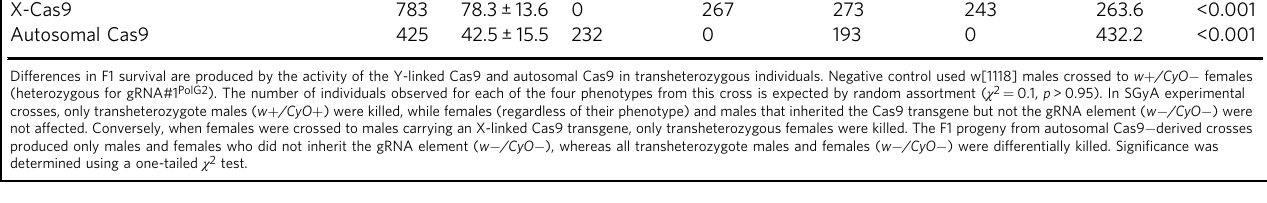
Table 3 Sex-speci fi c lethality driven by Y-linked Cas9 and X-linked Cas9 disrupting the PolG2 using homozygous females. ♂ (Cas9) line crossed to ♀ gRNA[ PolG2 #1] w + / gRNA[ PolG2 #1] w + line ( N = 10 crosses/line)